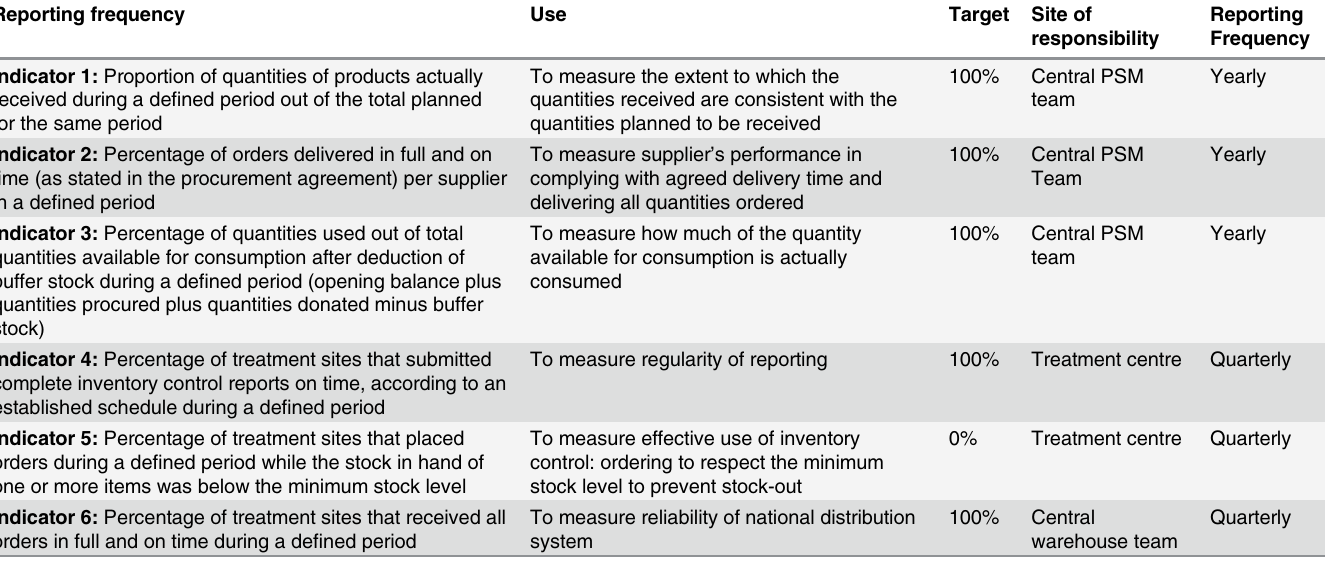
Table 1. Six early-warning indicators of stock-out and overstocking of the Procurement and Supply Management System (PSM) for MDR-TB drugs in Nigeria. Reporting frequency Use Target Site of